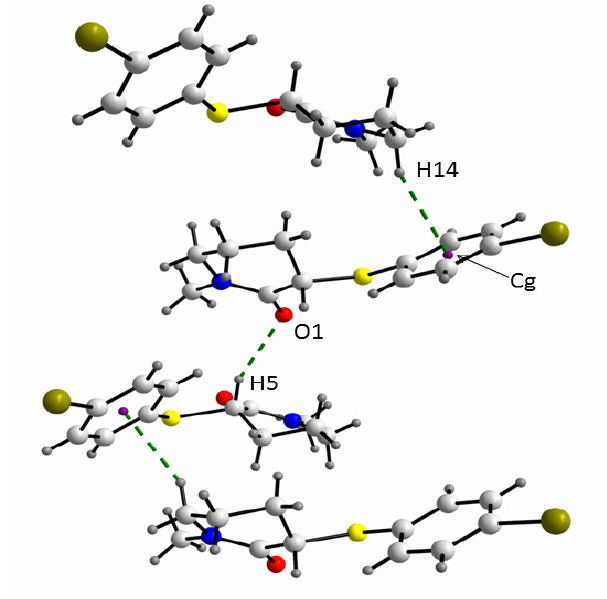
Figure 4. A view of the supramolecular array of 2 where the C-H…O and C-H…. π interactions are